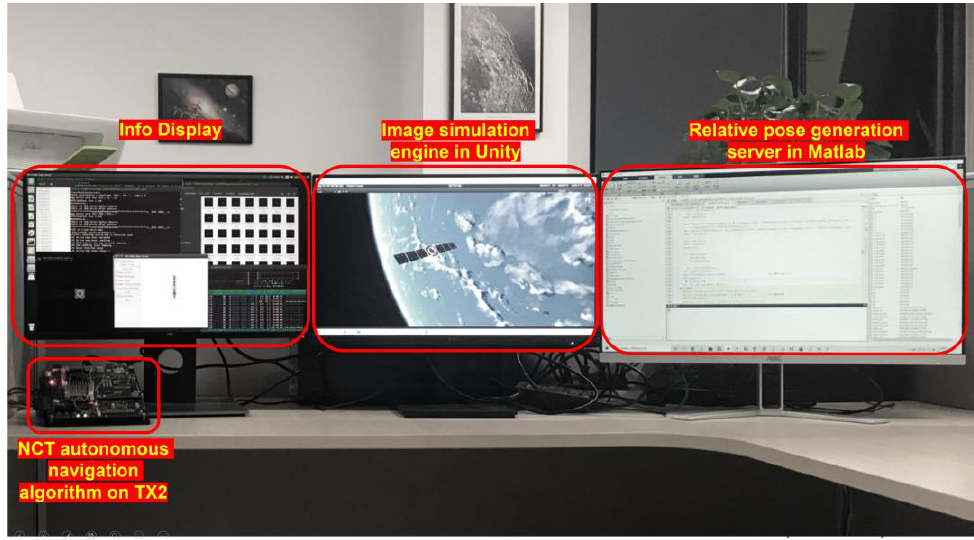
Figure 10. Hardware-in-the-loop (HIL) simulation platform.